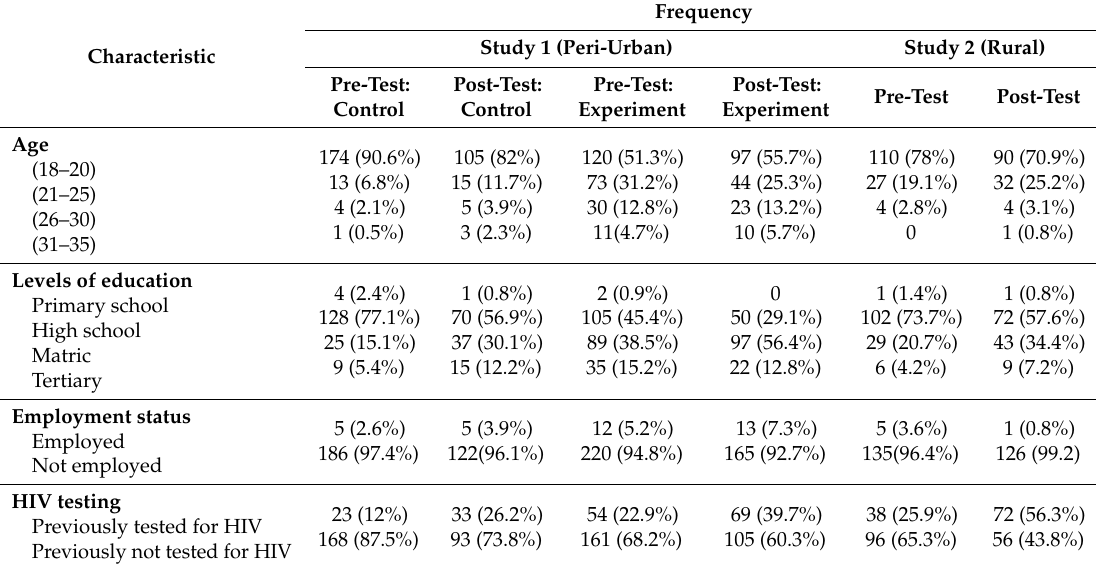
Table 1. Socio-demographic profile of the participants. Study 1 Experiment ( n = 236), Control ( n = 192), and Study 2 (all Experiment) ( n = 147).